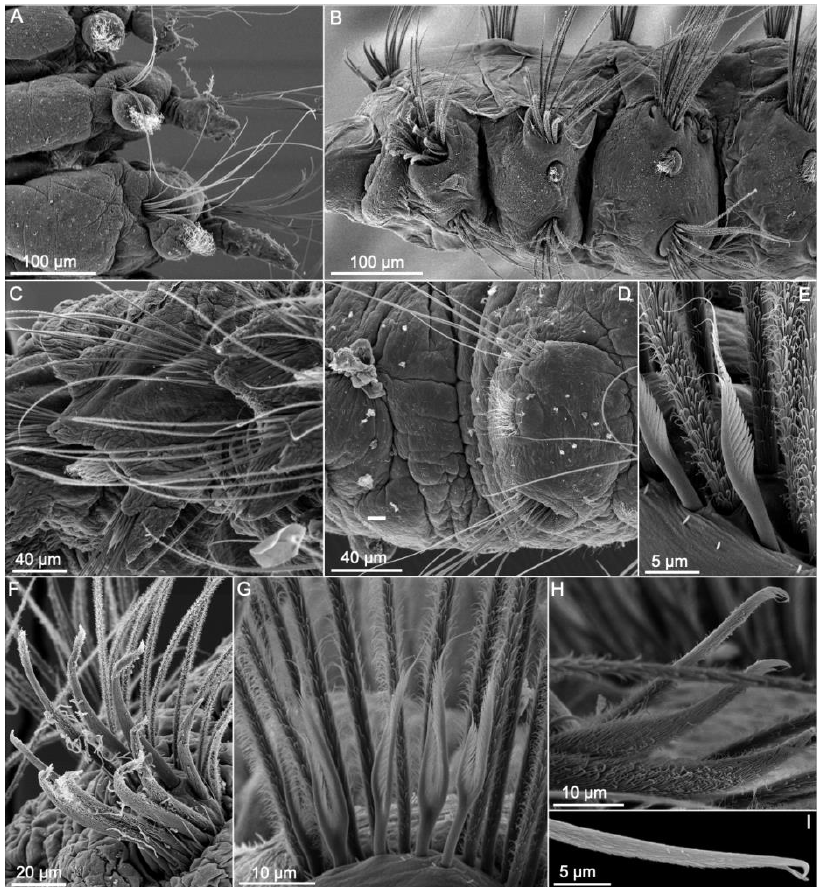
Figure 12. SEM micrographs of several Scalibregmatidae showing main diagnostic characters. ( A ) Speleobregma lanzaroteum, parapodia on the anterior segments in dorsal view, showing the presence of cirri; ( B ) Asclerocheilus sp., Canary Islands, parapodia on the anterior segments in lateral view; ( C ) Asclerocheilus sp., northwestern Spain, mid-body parapodium in frontal view; ( D ) Axiokebuita cavernicola , mid-body parapodium in frontal view; ( E ), Asclerocheilus sp., Canary Islands, lyrate chaetae on anterior segments in lateral view; ( F ) Asclerocheilus sp., northwestern Spain, spines on segment 1; ( G ) Asclerocheilus sp., Canary Islands, lyrate chaetae on mid-body segment; ( H ) Asclerocheilus sp., Canary Islands, spines; ( I ) S. lanzaroteum , geniculate